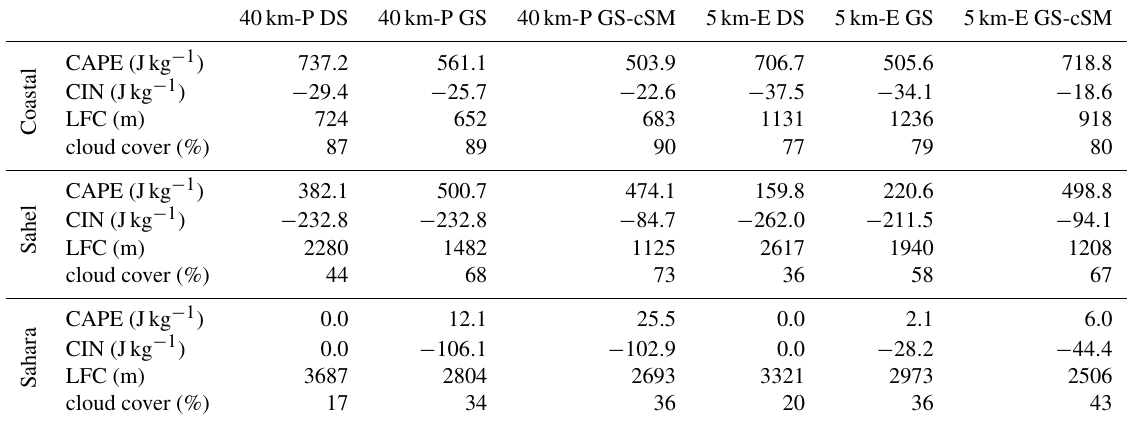
Table A3. The 12:00UTC JAS mean values of CAPE and CIN along with JAS mean values of the level of free convection (LFC) and total cloud cover for the coastal, Sahel, and Sahara region (Fig. 1), for the 40km-P DS, GS, and GS-cSM simulation, and for the 5km-E DS, GS, and GS-cSM